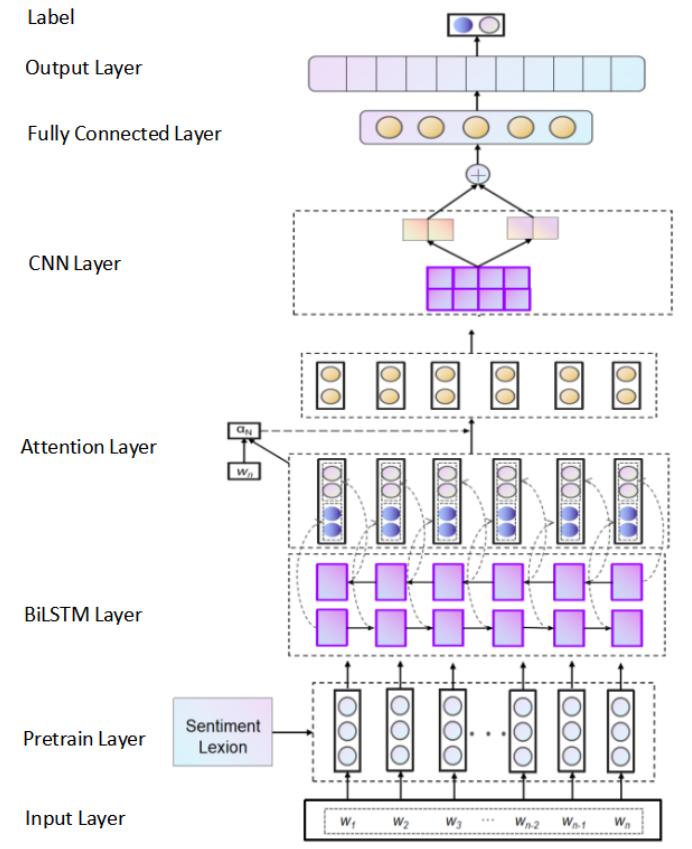
Figure 4. Proposed model